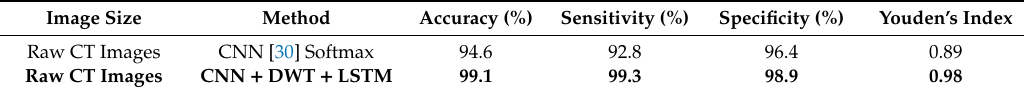
Table 5. Comparison with the study [30] that used the same database as this study.